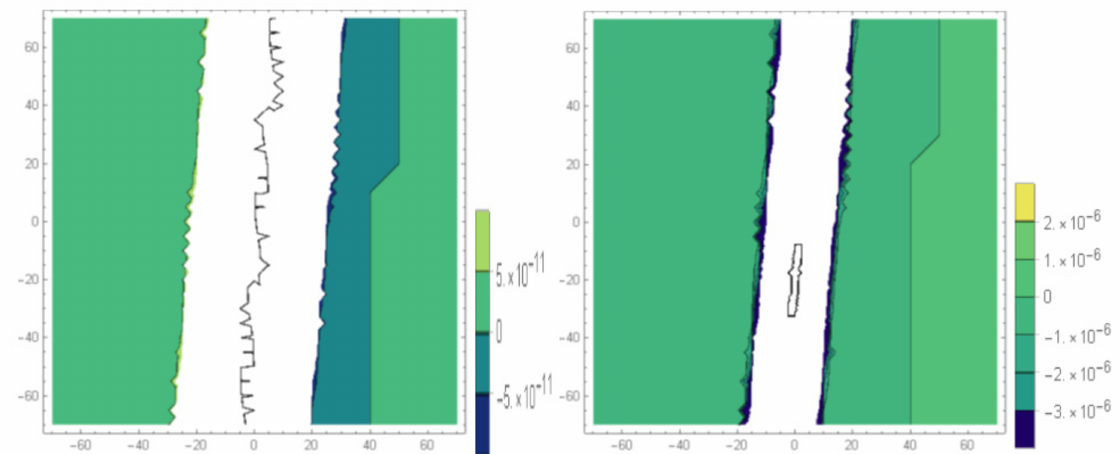
Figure 18. The contour surfaces of Equation (30) under the values of ε = 5, − 70 < x < 70, − 70 < t < 70.